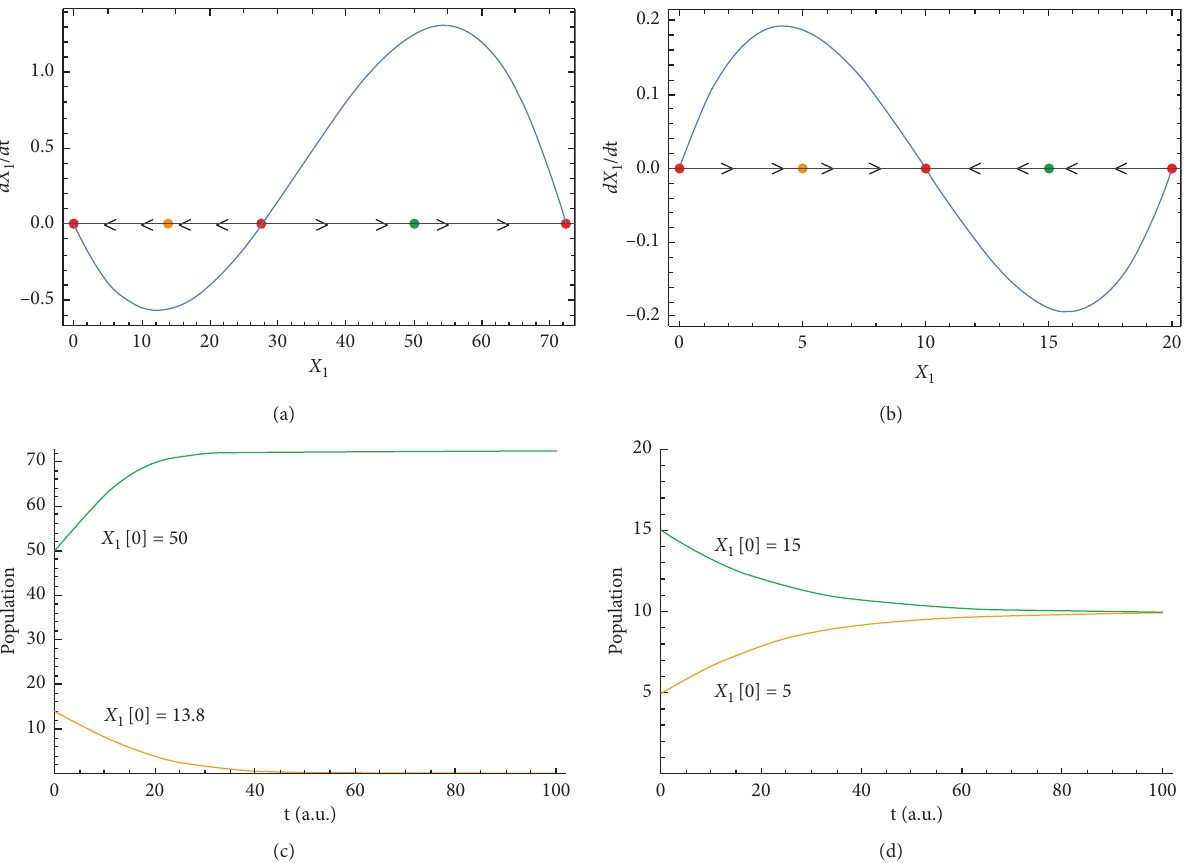
Figure 1: Temporal derivative (up) and population evolution (down) for one population with intraspecific interaction. Negative growth rate (left), r � − 0 . 1, with positive intraspecific interaction b � 0 . 005 and c � 0 . 005. Positive growth rate (right), r � 0 . 1, with negative intra- specific interaction b � − 0 . 015 and c � 0 .